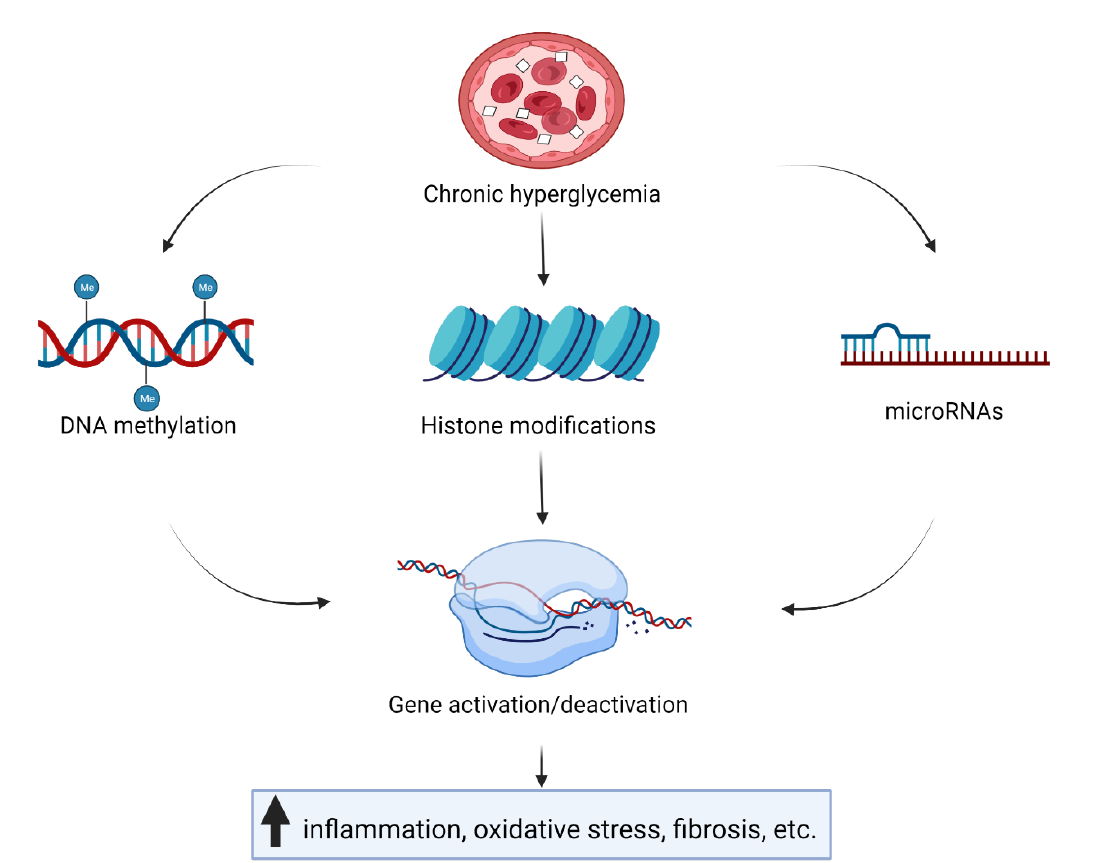
Figure 2. Chronic hyperglycemia influences gene transcription through epigenetic mechanisms— namely, DNA methylation, histone modifications, and microRNAs. The consequence is an increase in inflammation, oxidative stress, fibrosis, etc.